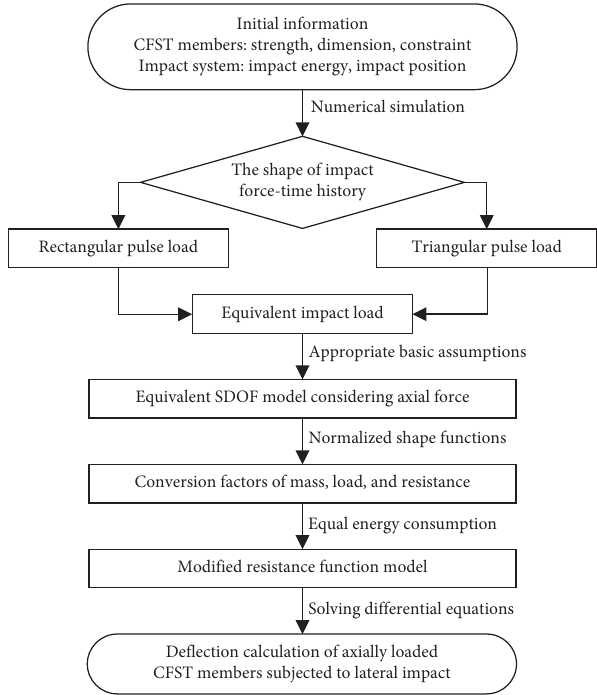
Figure 9: Flowchart for calculating the deflection of CFST